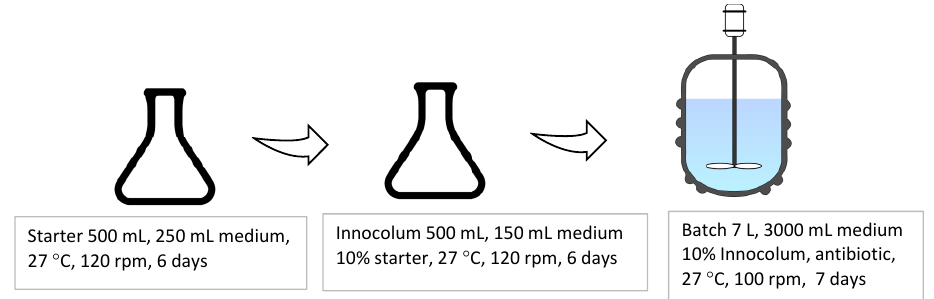
Figure 5. Cultivation step. Starter, inoculum, bench-scale batch reactor.